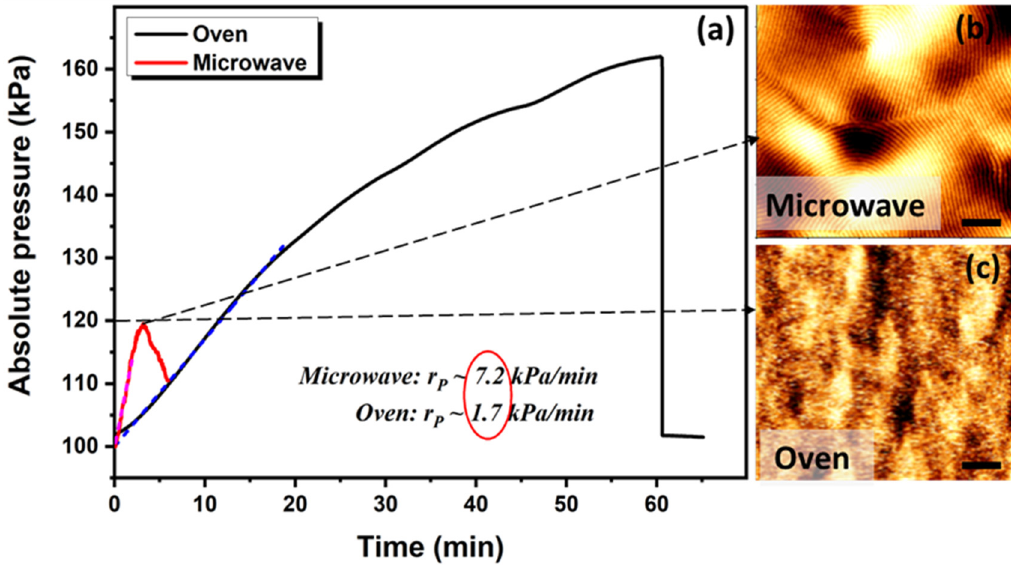
Figure 1. The effect of osmotic pressure ramp on phase separation. ( a ) In situ measurement of vapour pressure during annealing of PS- b -PLA film in conventional oven with lower ramp of ( r P = 1.7 kPa/min ) , and in the microwave with the rapid pressure ramp of ( r P = 7.2 kPa/min ) . Topographic AFM images of the SVA film in the microwave ( b ), and oven ( c ), at the point when the vapour pressure reached 120 kPa. Scale bars are 300 nm.